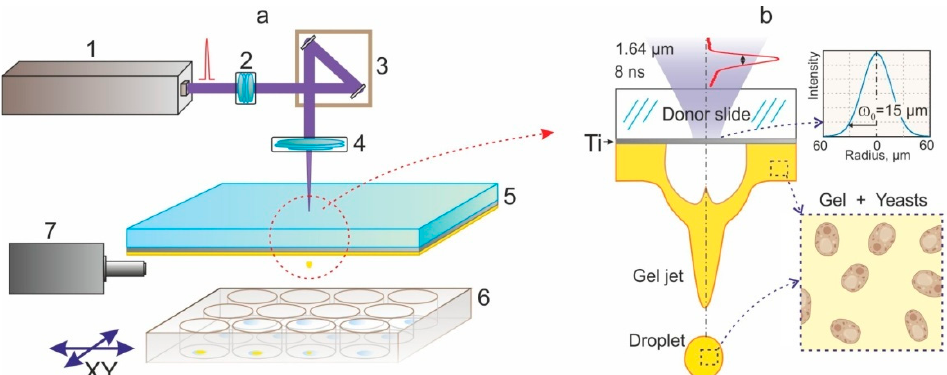
Figure 1. Schematic of the bioprinting setup. ( a )—Sketch of experimental setup for laser bioprinting. 1—pulsed laser (1064 nm, 8 ns), 2—beam shaper, 3—galvanoscanner, 4—objective, 5—donor substrate with gel layer, 6—bioplate, 7—high-speed camera. ( b )—schematic representation of a part of a